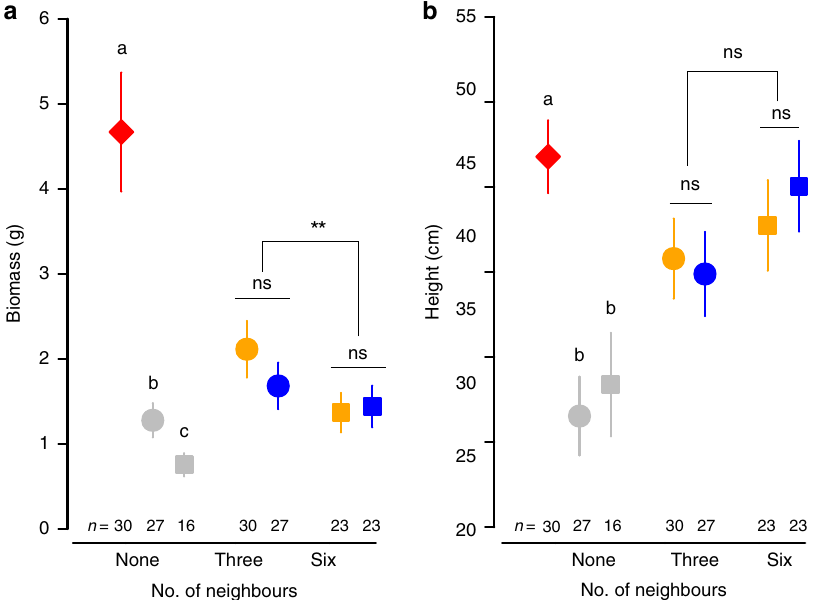
Fig. 2 Effect of intraspeci fi c social environment on plant size. Least-square means (± s.e.m.) of a plant above-ground biomass, and b plant height. Focal plants were grown alone, with three neighbours, or with six neighbours, which were either kin (orange symbols) or non-kin (blue symbols). Solitary plants were grown in large (red diamonds), medium-sized (grey circles) and small pots (grey squares). Different letters indicate signi fi cant differences between solitary plants (GLMM test: P < 0.05, Supplementary Table 3), whereas differences between kin and non-kin treatments, and between levels of group size, are indicated above the symbols (GLMM test: ns, P > 0.05; *, P < 0.05, Table 1). P -values of comparisons between solitary plants vs. focal plants within groups are shown in Supplementary Table 2. All P -values were corrected for multiple comparisons using Holm ’ s